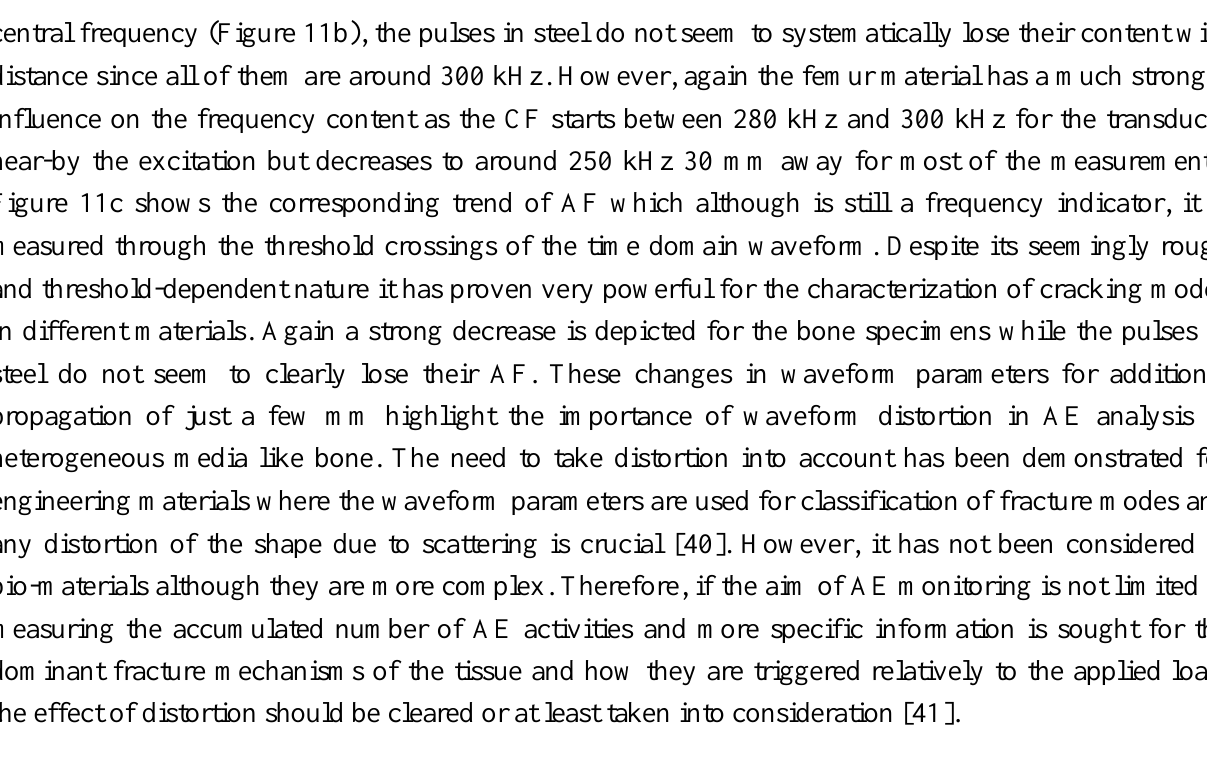
Figure 10. Typical AE waveform with basic parameters.